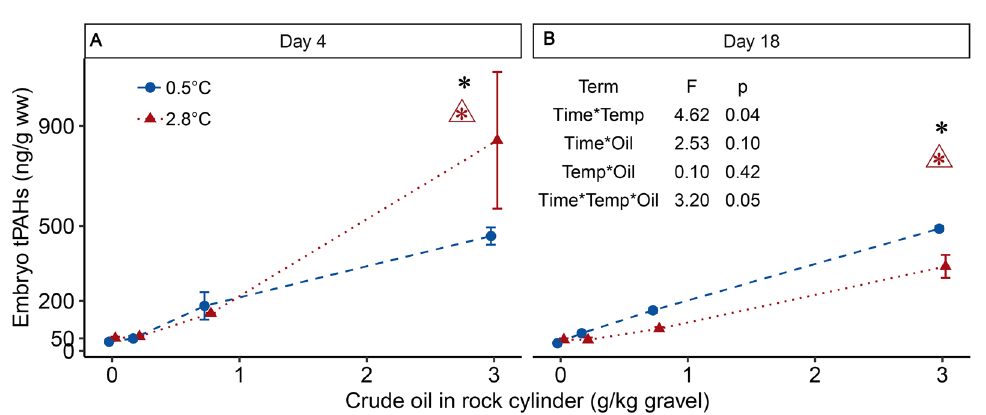
Figure 2. The effect of temperature and WSF crude oil exposure on tPAH levels (ng/g ww) in embryos on ( A ) day 4 and ( B ) day 18 displayed as treatment means (± SEM depicted as bars, each treatment is represented by two independent pools of two incubators), plotted on a log scale. Colors, symbols, and line types distinguish the temperature groups. The best linear mixed effect (LME) model was tPAH ~ time*factor(temperature)*fac tor(oil treatment) and ANOVA f-values and p-values for the interactions are displayed. An asterisk (*) above a treatment group indicates a statistically significant difference from the unexposed group, a triangle (open triangle) with an asterisk indicates a statistically significant interaction between temperature and crude oil exposure at the adjacent crude oil treatment group. Embryos were at different development stages during the sampling; Day 4: late cleavage stage (0.5 °C) and blastulation (2.8 °C); Day 18: early organogenesis (0.5 °C) and mid organogenesis (2.8